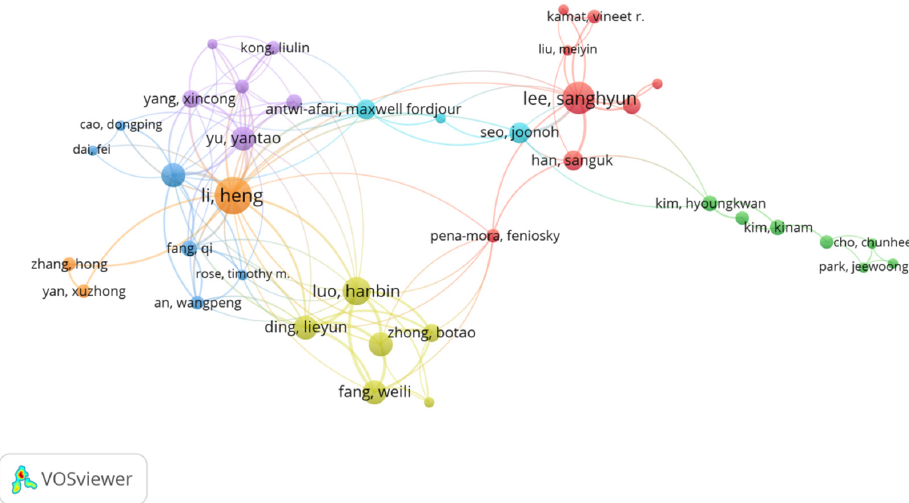
Figure 7 . Author collaboration network. Figure 7. Author collaboration